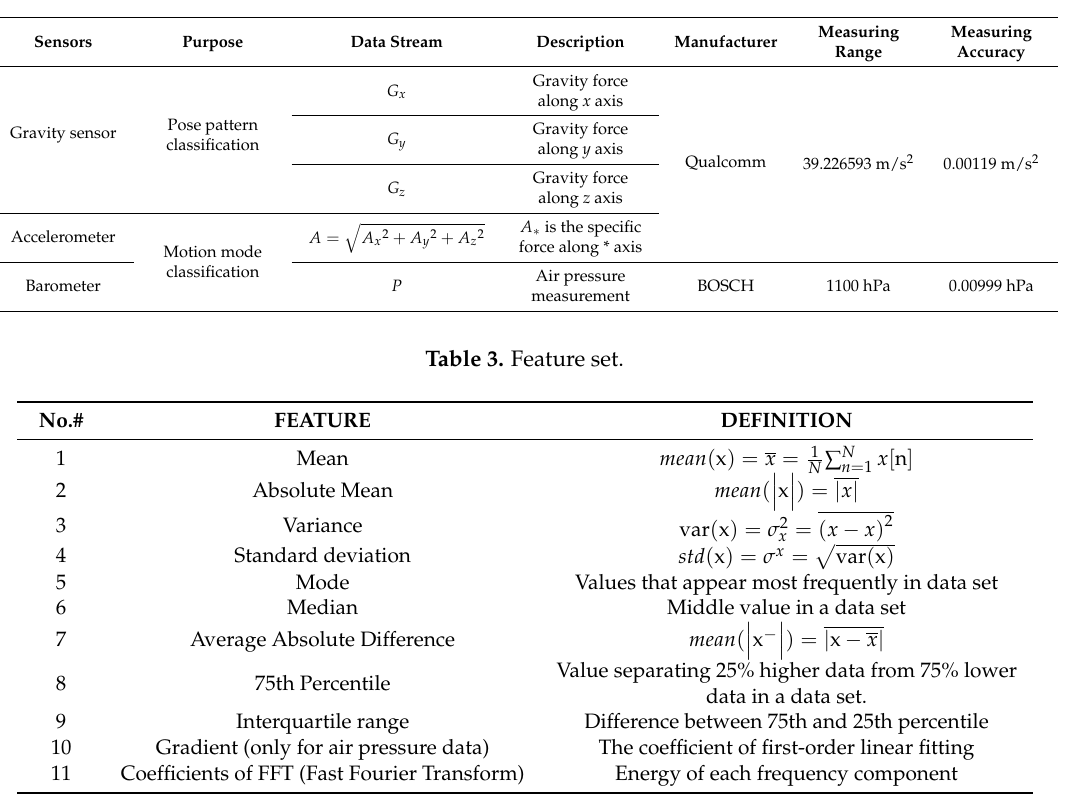
Table 2. Description of adopted smartphone sensors.